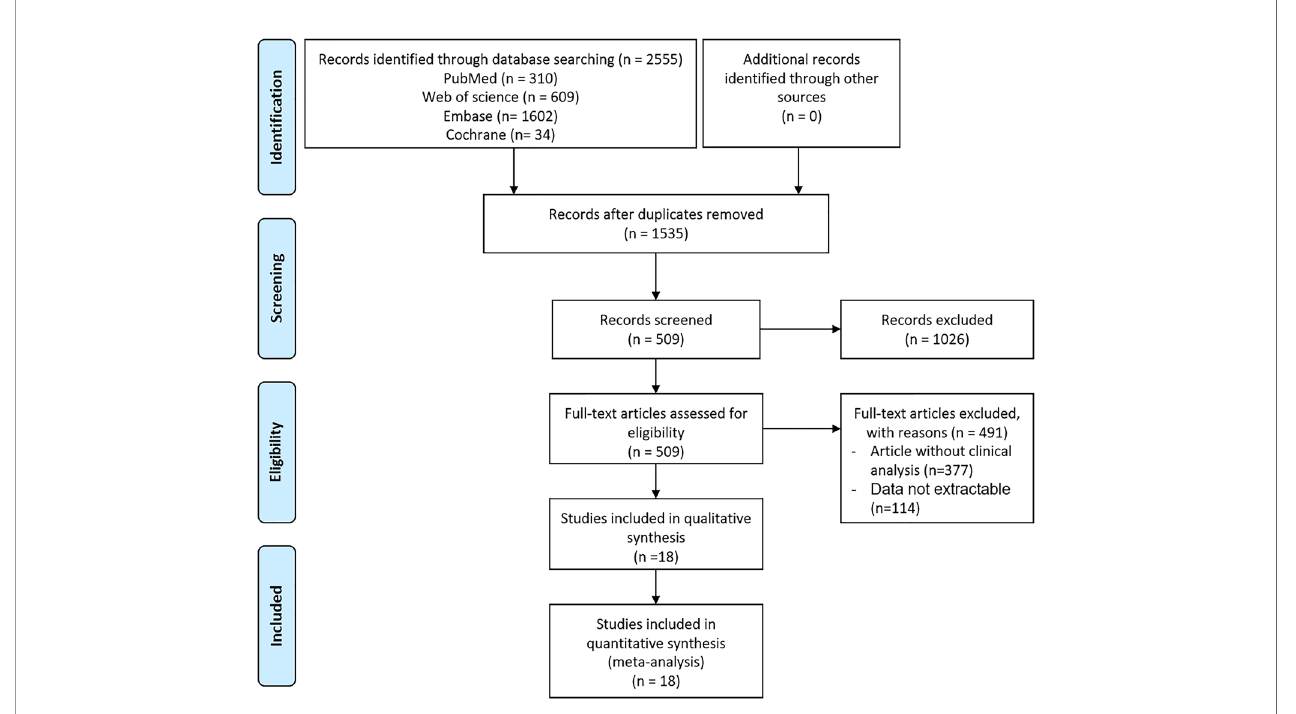
FIGURE 1 | Flow diagram of the study selection